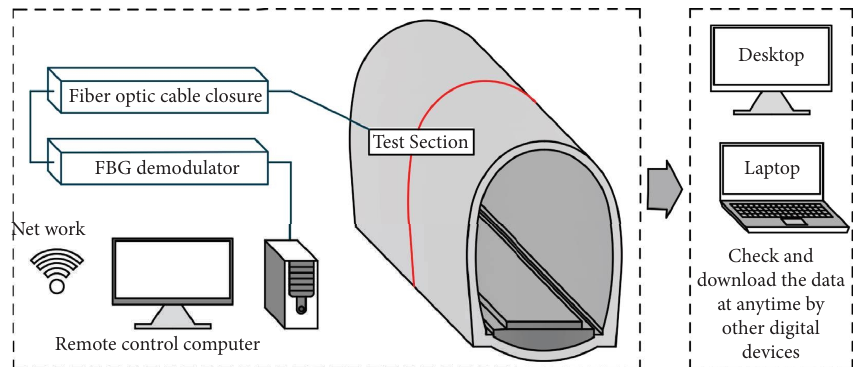
Figure 6: Remote monitoring system of the double-track heavy-haul railway tunnel.